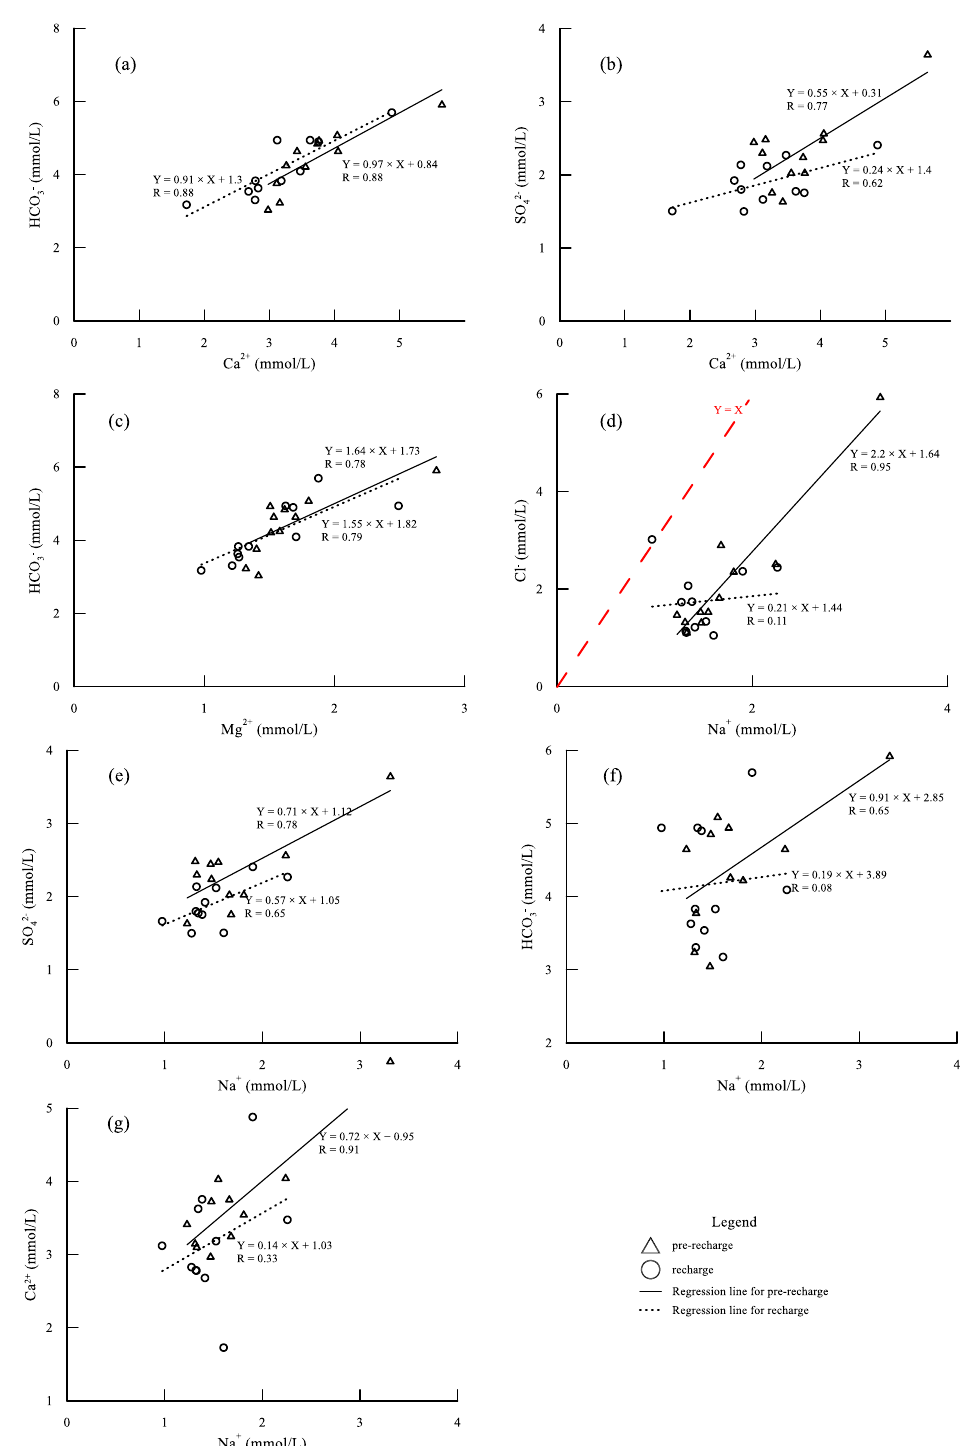
Figure 5. Relationship between the main ion pairs in groundwater. ( a ) Relationship between Ca 2+ and HCO 3 − . ( b ) Relationship between Ca 2+ and SO 4 2− . ( c ) Relationship between Mg 2+ and HCO 3 − . ( d ) Relationship betweenNa + and Cl − . ( e ) Relationship betweenNa + and SO 4 2− . ( f ) Relationship between Na + and HCO 3 − . ( g ) Relationship between Na + and Ca 2+ .